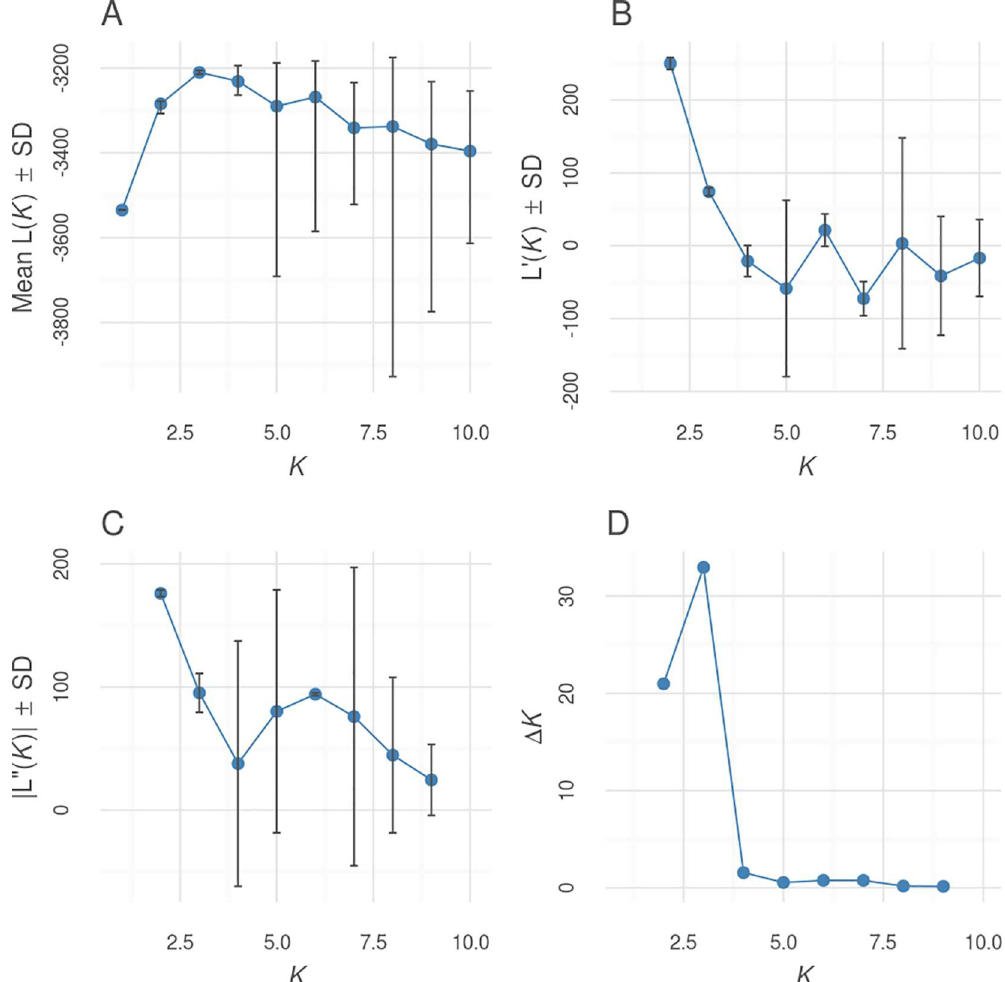
Fig 3. Results of the global STRUCTURE analysis in Mesoamerican jaguars. The optimal number of genetic clusters ( K ) in Mesoamerican jaguars ( n = 115) applyingBayesian clustering methods in STRUCTURE, version 2.3.4 [47] was chosen based on posterior probabilities (mean L( K ); A) and delta K ( Δ K , mean (|L”( K )|)/SD(L( K )); D) for each K value. SD, standard deviation; L’( K ), mean rate of change of the likelihooddistribution(B); |L”( K )|, absolute value of the 2 nd order rate of changeof the